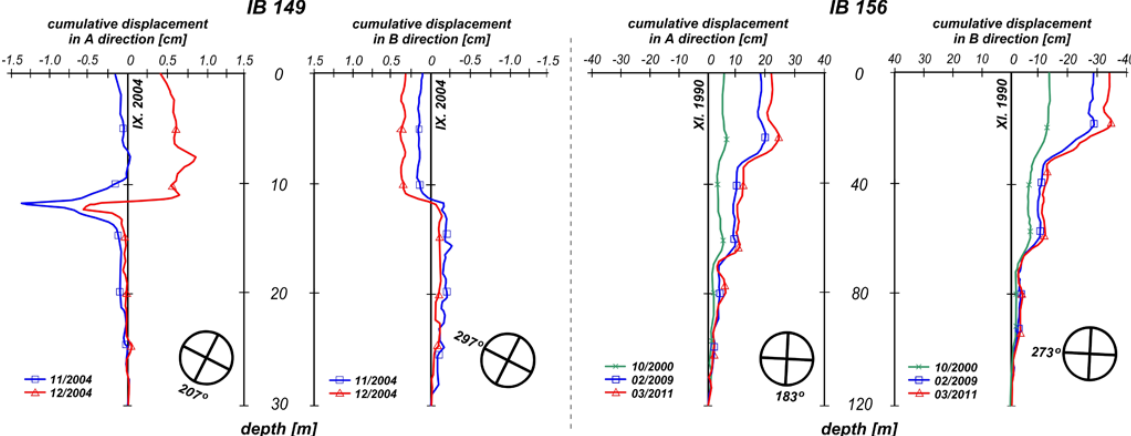
Fig. 7. Selected inclinometric boreholes – cumulative displacement. IB 149 was placed within the landslide body; the initial shear failure is obvious at the depth of 12m – last measurement was in December 2004. Two zones of possible shear failure are visible in IB 156 placed near the January 2012 landslide. The main landslide activity was reflected also in this borehole when the shift of 60mm was found in the upper shear